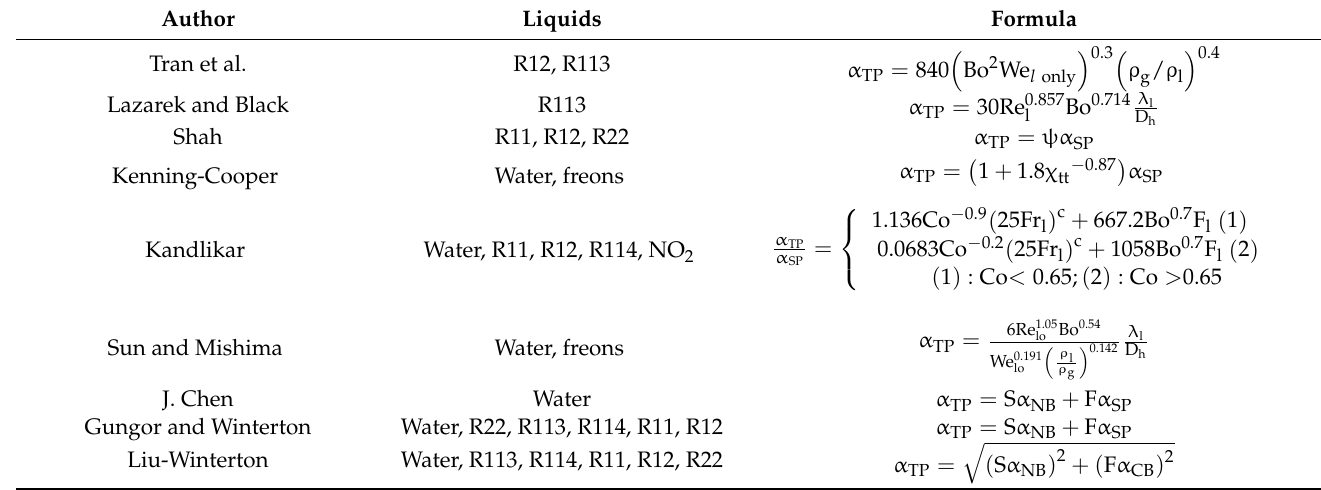
Table 1. List of works indicating calculation